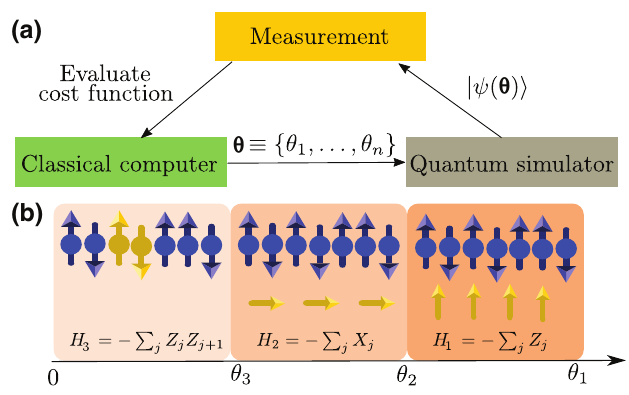
FIG. 1. (a) A schematic illustrating a variational quantum- classical optimization routine. The optimization involves n parameters θ i , where i = 1, 2, . . . , n . For the ansatz in Eq. (1), n = pM . (b) The ( M = 3)-step QAOA protocol for the prepara- tion of the ground state of the Ising model in both transverse and longitudinal fields, discussed in Sec.